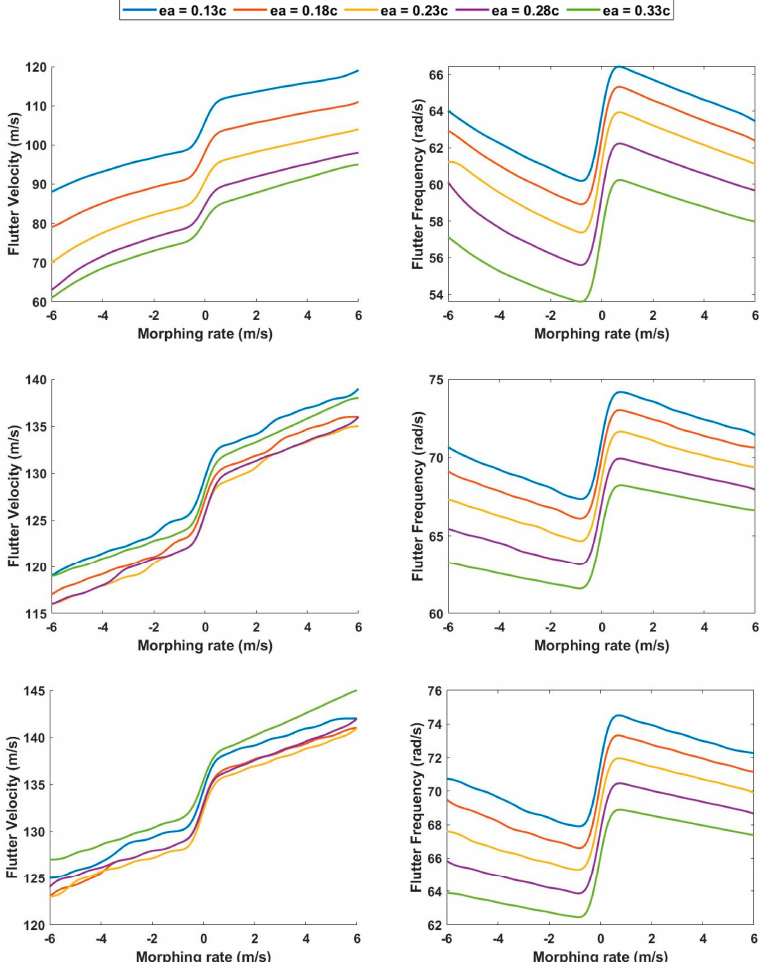
Figure 8. Left: Flutter Velocity vs. morphing rate for span of 6.111 m. Right: Left: Flutter Frequency vs. morphing rate for span of 6.11 m. Top : GJ = 1% of baseline wing. Middle : GJ = 10% of baseline wing. Bottom : GJ = 100% of baseline wing.